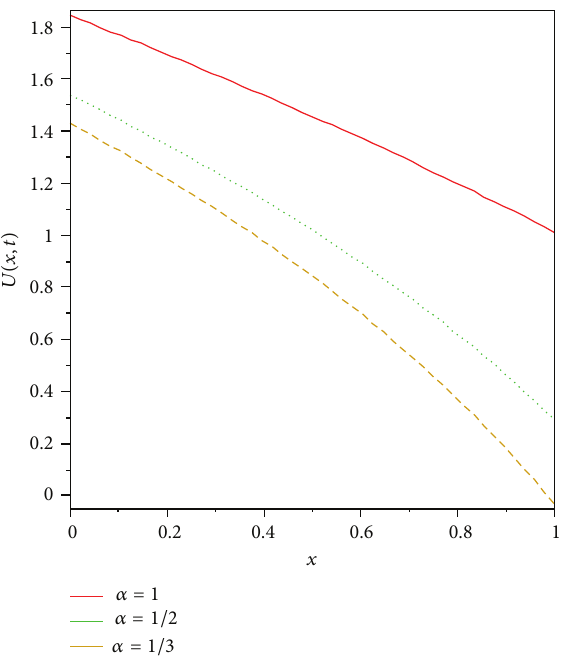
Figure 2: Plots of 𝑈(𝑥,𝑡) versus 𝑥 at 𝑡 = 1 for different values of 𝛼 .